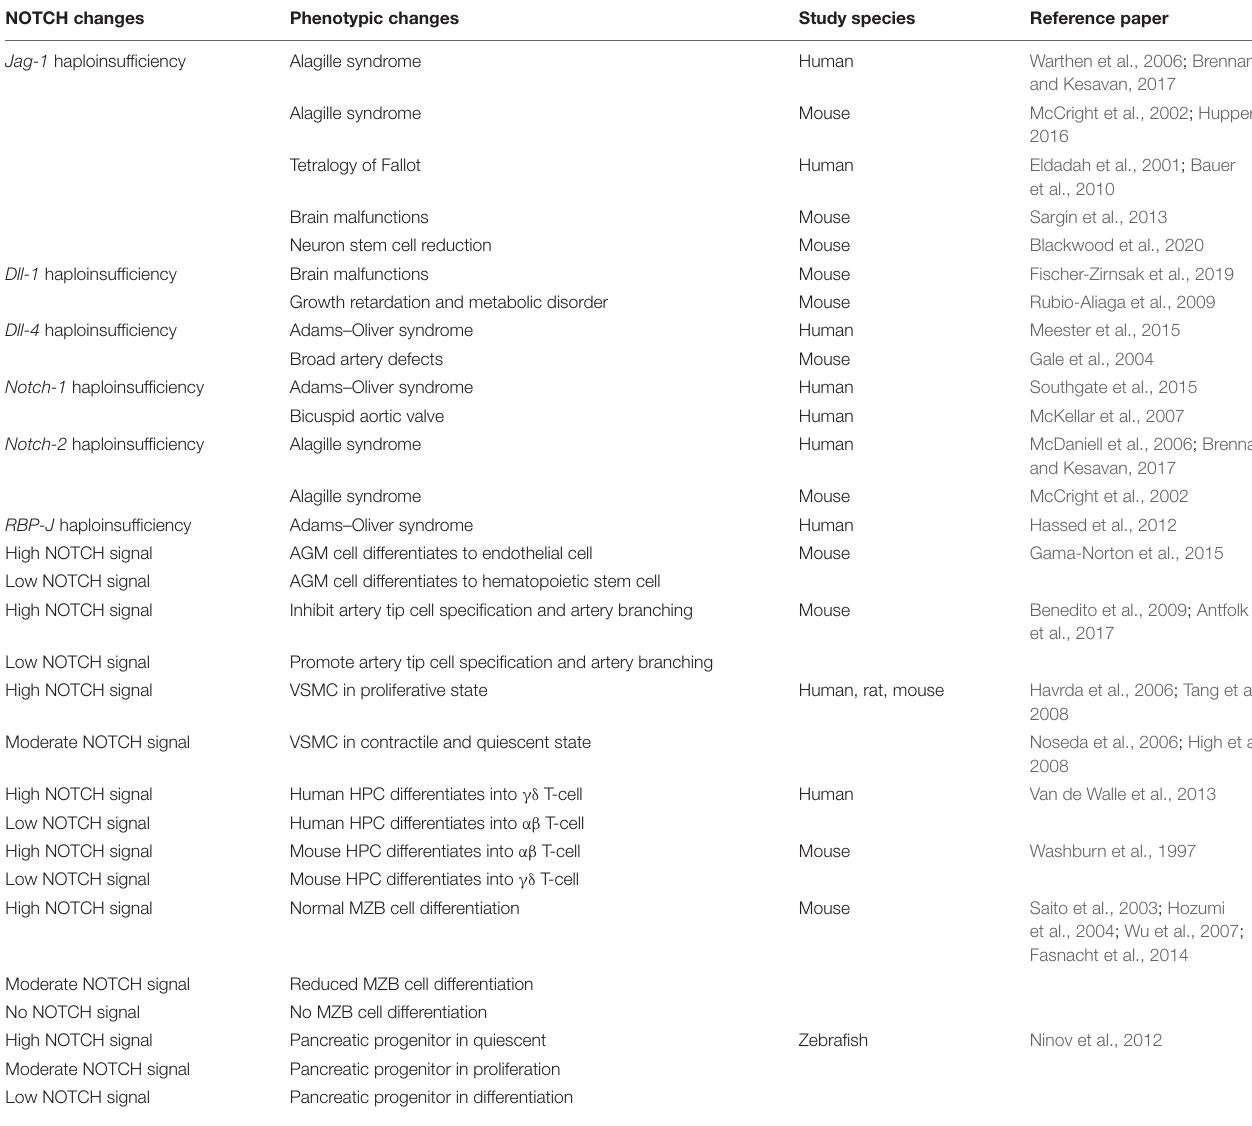
TABLE 1 | Developmental processes sensitive to NOTCH signaling